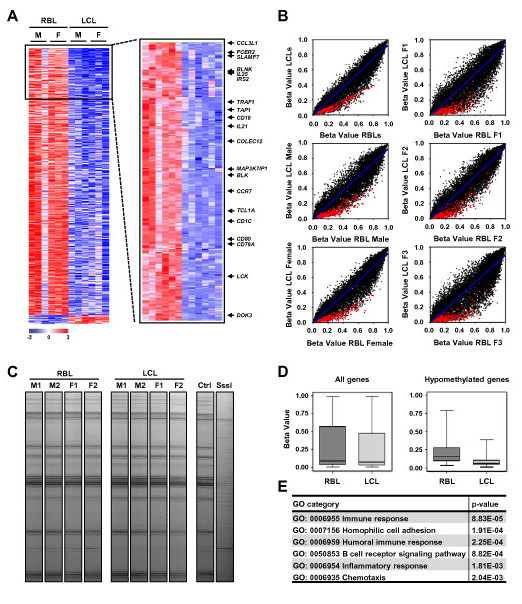
High-throughput methylation comparison of resting B lymphocytes and matching lymphoblastoid cells. (a) Heatmaps including the data for the six RBL/LCL pairs of samples showing significant differential methylation. The left panel shows all the genes showing a FDR < 0.05. Only those genes with a FC > 2 were selected (right panel). Data from the Illumina array were normalized as xi = xi - row.mean[i])/(0.333 × row.sd[i]). A scale is shown at the bottom, whereby positive (red) and negative (blue) values correspond, respectively, to higher and lower than average methylation status. M, male; F, female. (b) Scatterplots showing methylation profiles of matching RBL/LCL pairs. Genes with significant differences (FC > 2, FDR < 0.05) in averaged results from six samples are highlighted in red. Six panels are shown: top left, mean of six experiments/pairs of samples; middle left, male samples; bottom left, female samples; right panels, three individual RBL/LCL comparisons. (c) Band patterning corresponding to the analysis of unmethylated/methylated Alu (AUMA) repeats. Four RBL/LCL (M, male; F, female) pairs are shown. To illustrate the sensitivity toward DNA methylation changes, a B cell sample is compared with the same sample following limited treatment with SssI DNA methyltransferase. (d) Comparison of the methylation levels in RBLs and LCLs for all the CpGs represented in the 27k bead array and CpGs that undergo hypomethylation in this process. Box and whisker plots are presented, where the bottom and top of the box are the 25th and 75th percentile and the bar near the middle is the 50th percentile (the median). (e) Gene Ontology (GO) analysis of hypomethylated genes during EBV-mediated RBL to LCL conversion.